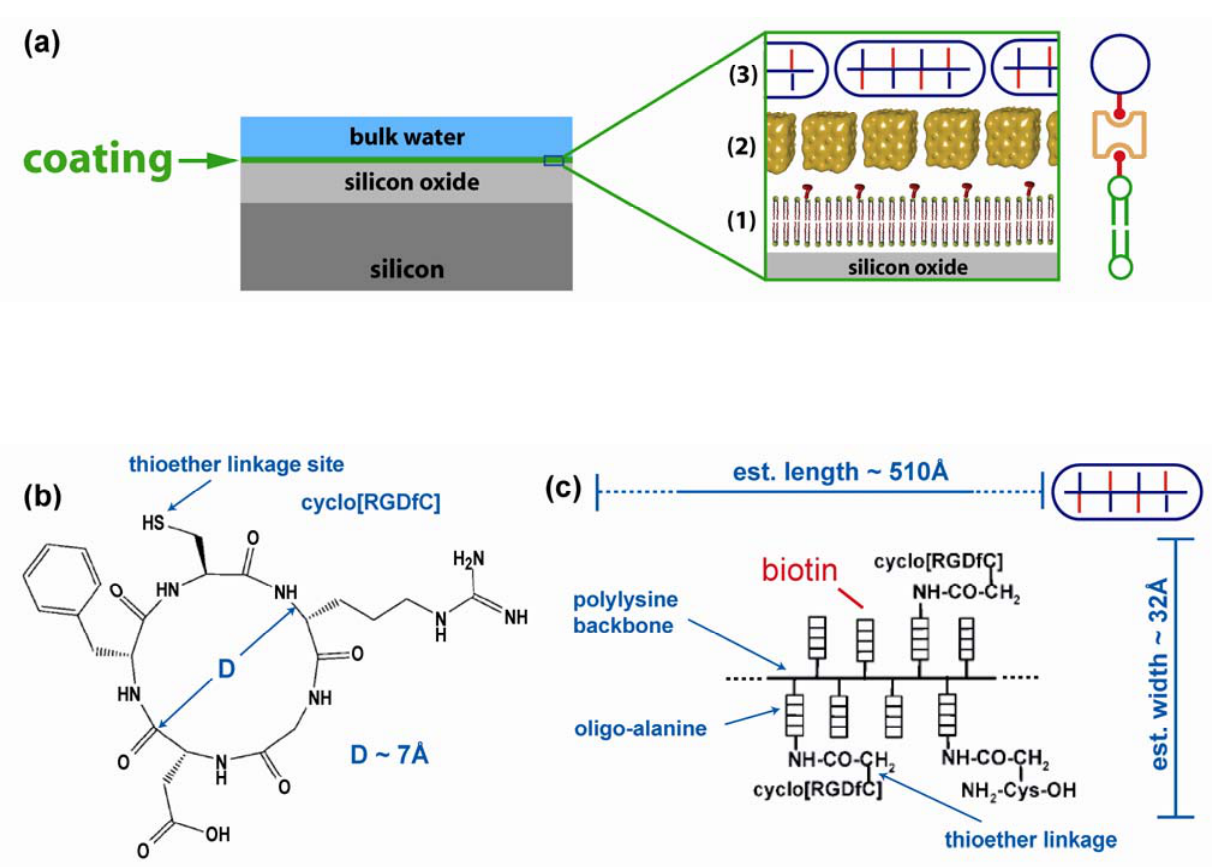
Figure 1. Schematics. ( a ) Sample structure. The lipid bilayer containing 2% of biotinylated lipids (1) is covered by a layer of streptavidin (2) which is bound to the lipid membrane by biotin anchors. A biotinylated adhesion peptide (AK-cyclo[RGDfC]) is bound on top of the streptavidin layer (3); ( b ) Chemical structure of the cyclic RGD-containing binding residue; ( c ) Architecture of the adhesion peptide. (b) and (c) are adapted from